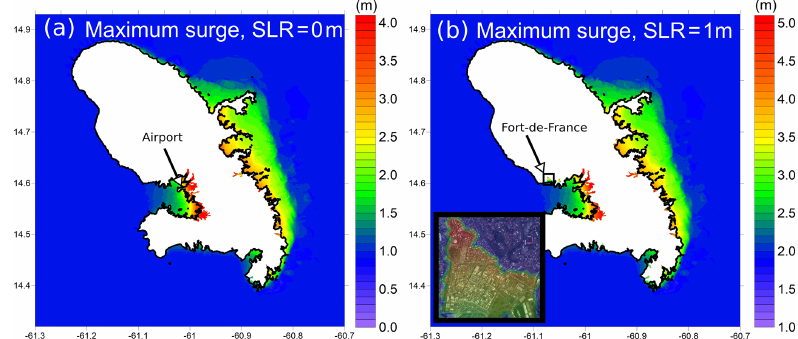
Figure 6. Maximum surges obtained by considering worst case (category 4–5) hurricanes hitting Martinique, without (a) and with (b) sea level